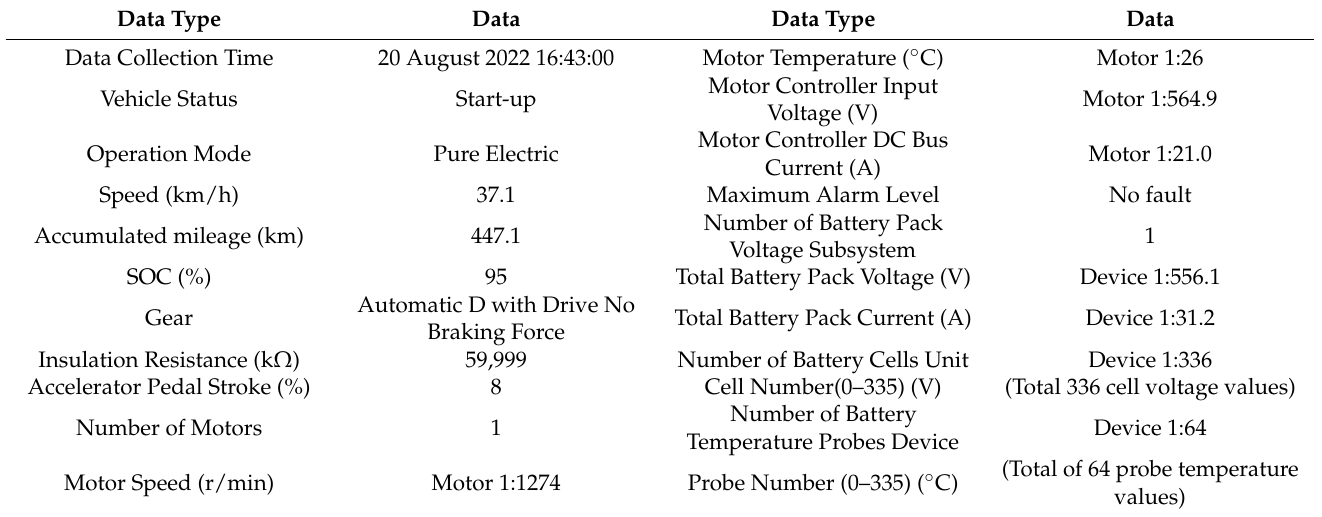
Table 1. The data format of a data